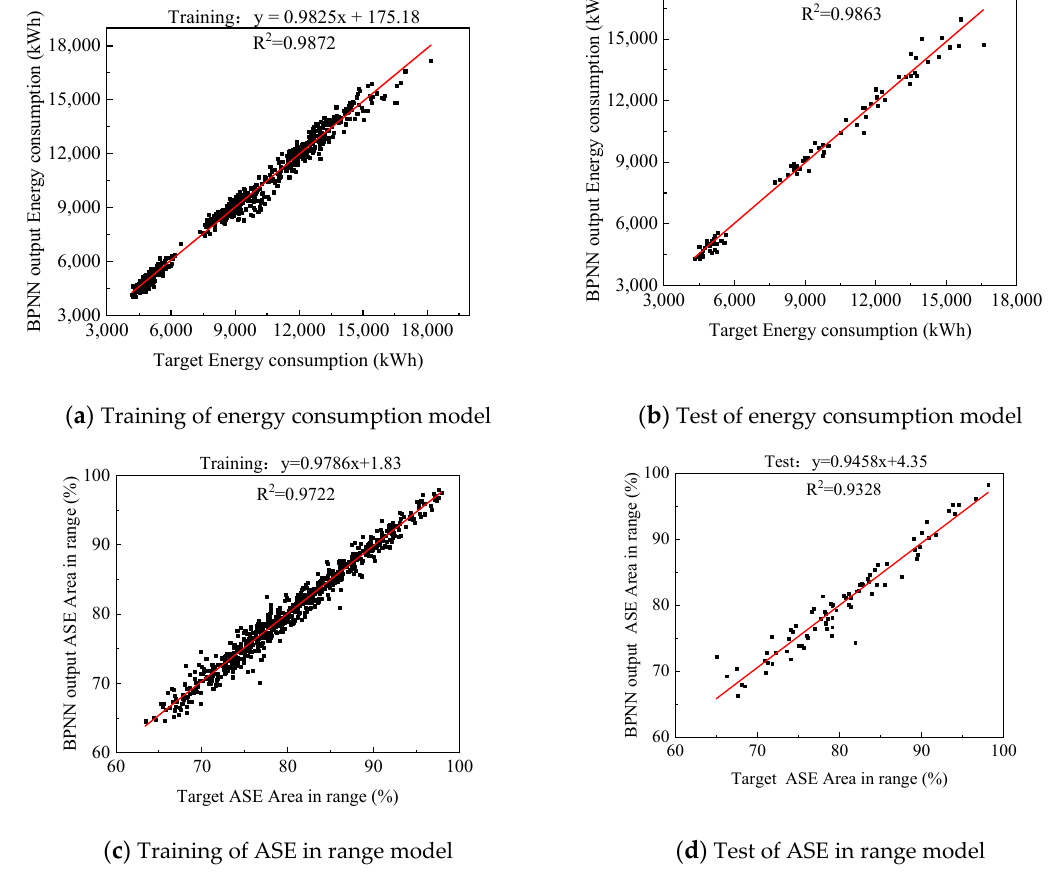
Figure 5. Neural network model output and target fitting diagram.